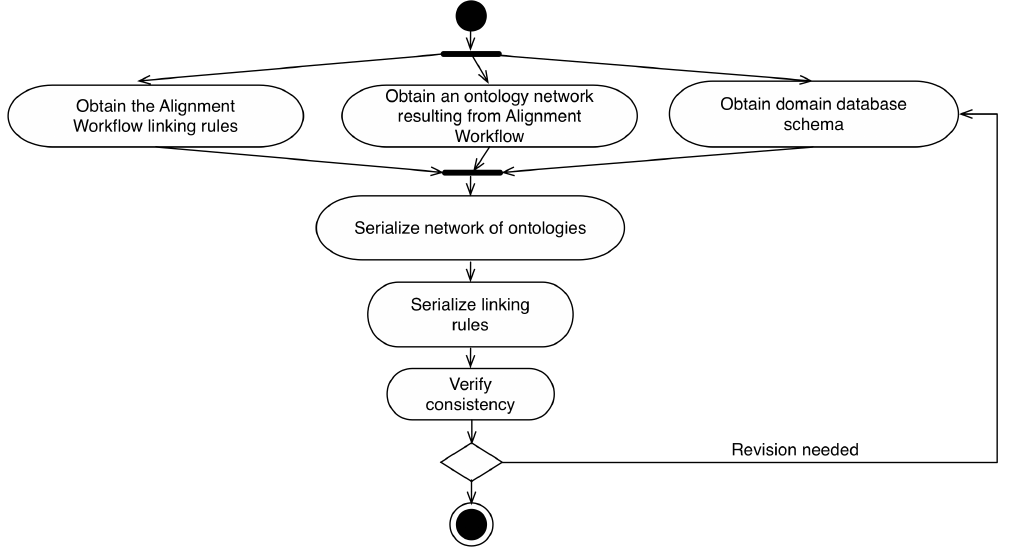
Figure 8. Overview of Serialization